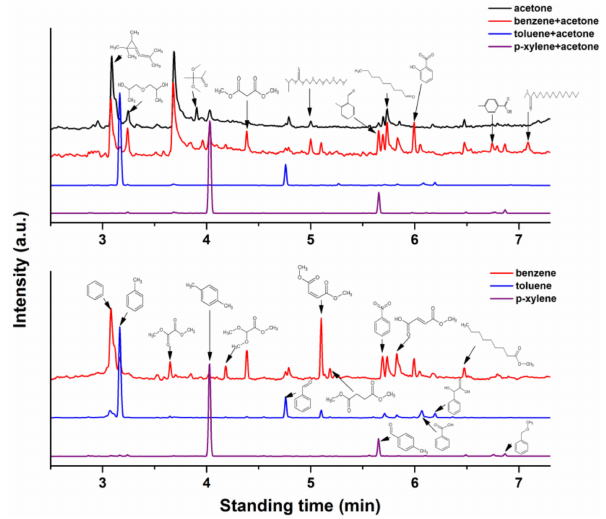
Figure 9. GC-MS results of the outlet gas at ED = 1600